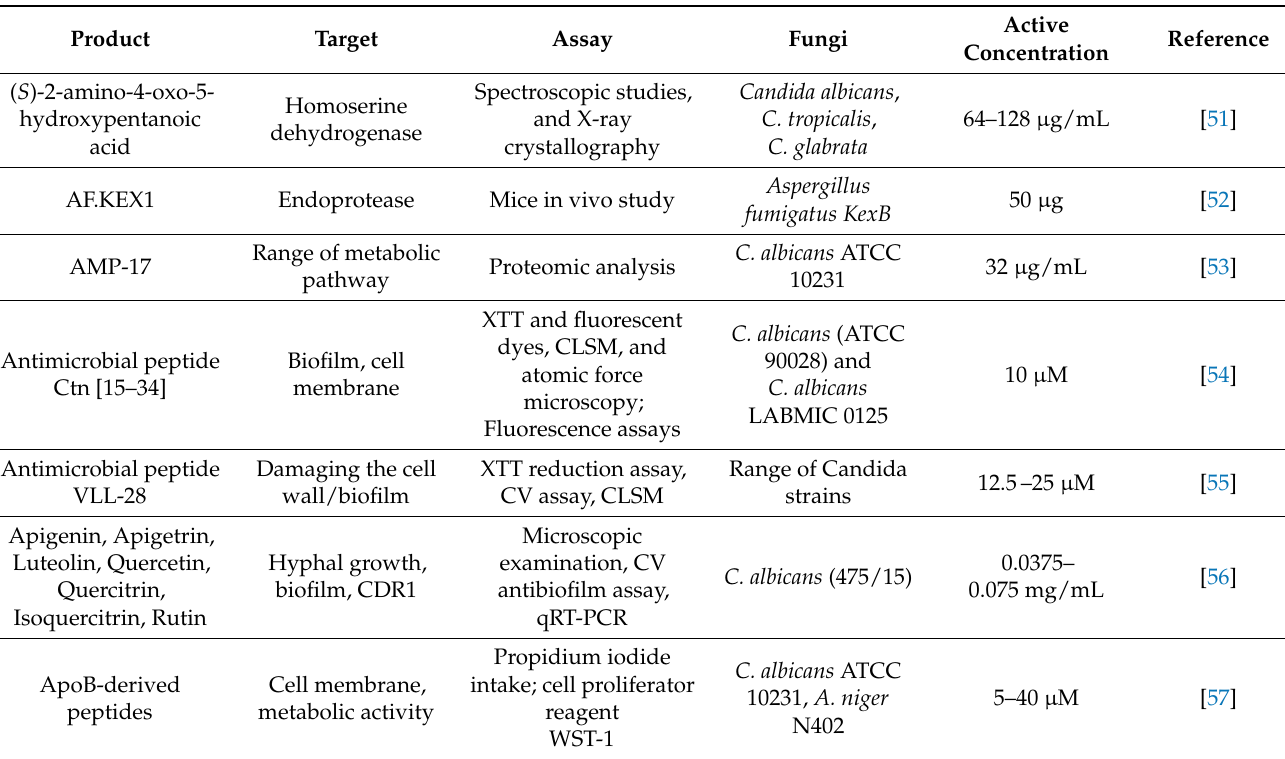
Table 1. Overview of some of the agents recently explored as antifungals targeting different struc- tures/processes in fungal cells. (-)—not